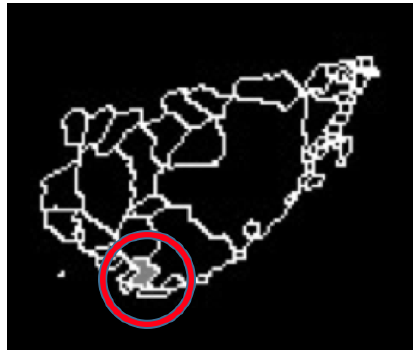
Figure 21. Hottest point detected in the right breast for Case 4 indicating the location of a cancer